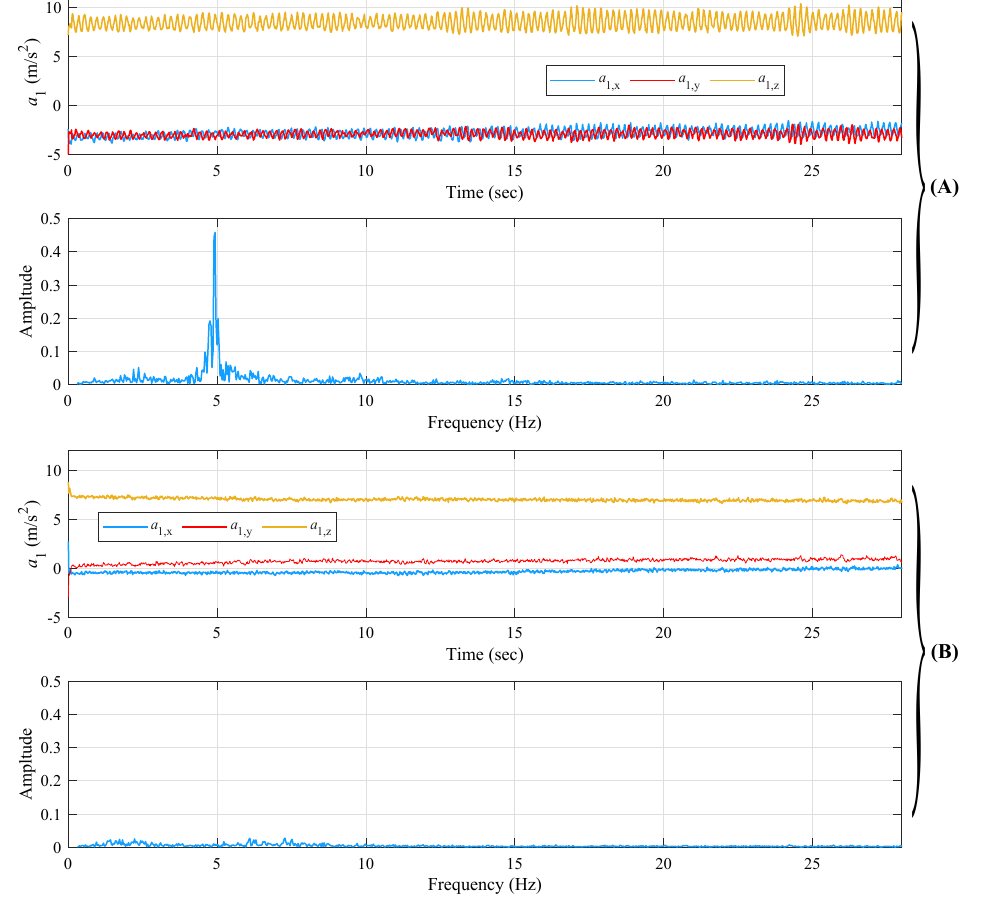
Figure 8. Indicative accelerometer measurements and respective frequency spectrum, as acquired from the index measurement point and the extended arm pose I 2 of ( A ) an ET-diagnosed patient and ( B ) a volunteer with no visible tremor